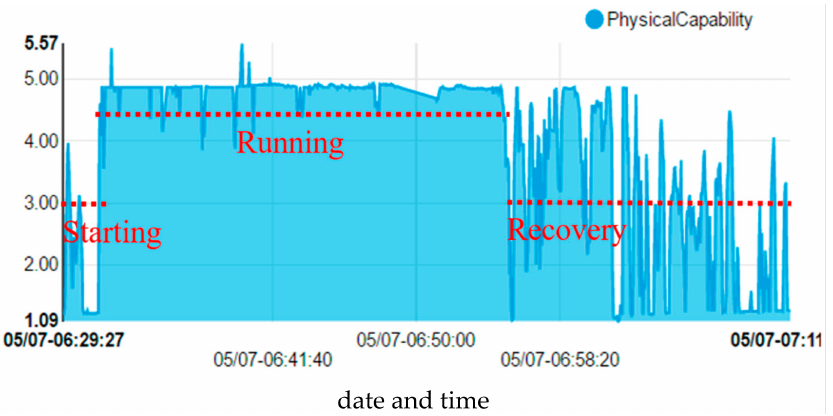
Figure 17. Physical indicator monitoring records.